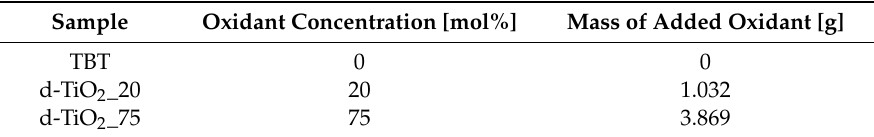
Table 5. HIO 3 concentrations used for the synthesis of each d-TiO 2 photocatalyst.